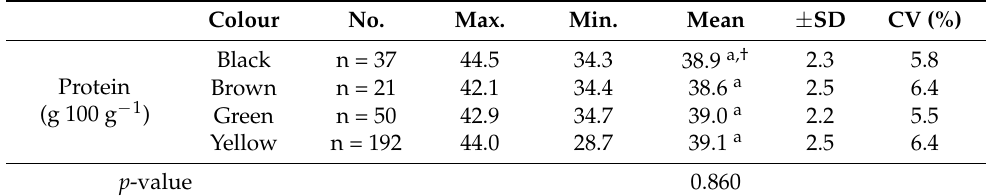
Table 4. Maximum, minimum and mean value of protein contents according to seed colour in 300 soybean germplasms. Colour No. Max. Min.